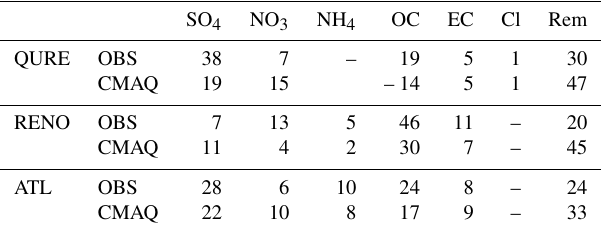
Table 1. Concentration share (%) of different components in total PM 2 . 5 . It is estimated by dividing the mean trend components of each species by that of total PM 2 . 5 for both OBS and CMAQ, mul- tiplied by 100. The concentration share of the remainder species, Rem, is estimated by subtracting all the available species’ share from 100 to compensate for the small discrepancies caused by the rounding up process and uncertainty in the mode decomposition. “–” indicates the data are not available (same applies for all other tables).